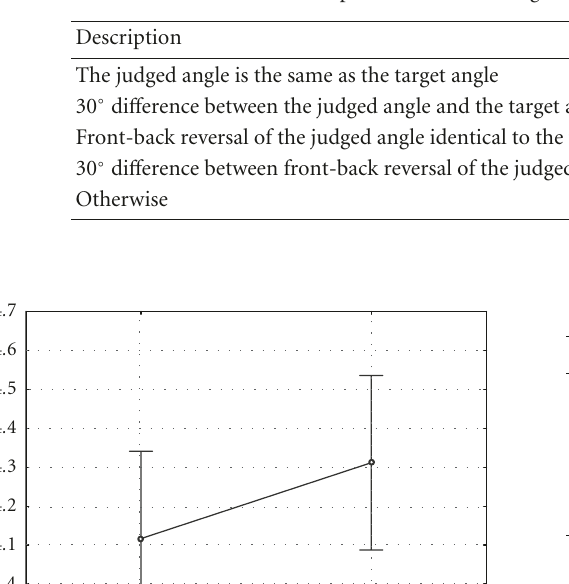
Table 3: The comparison of computation loading of the fullband CCS and the bandlimited CCS with direct convolution.